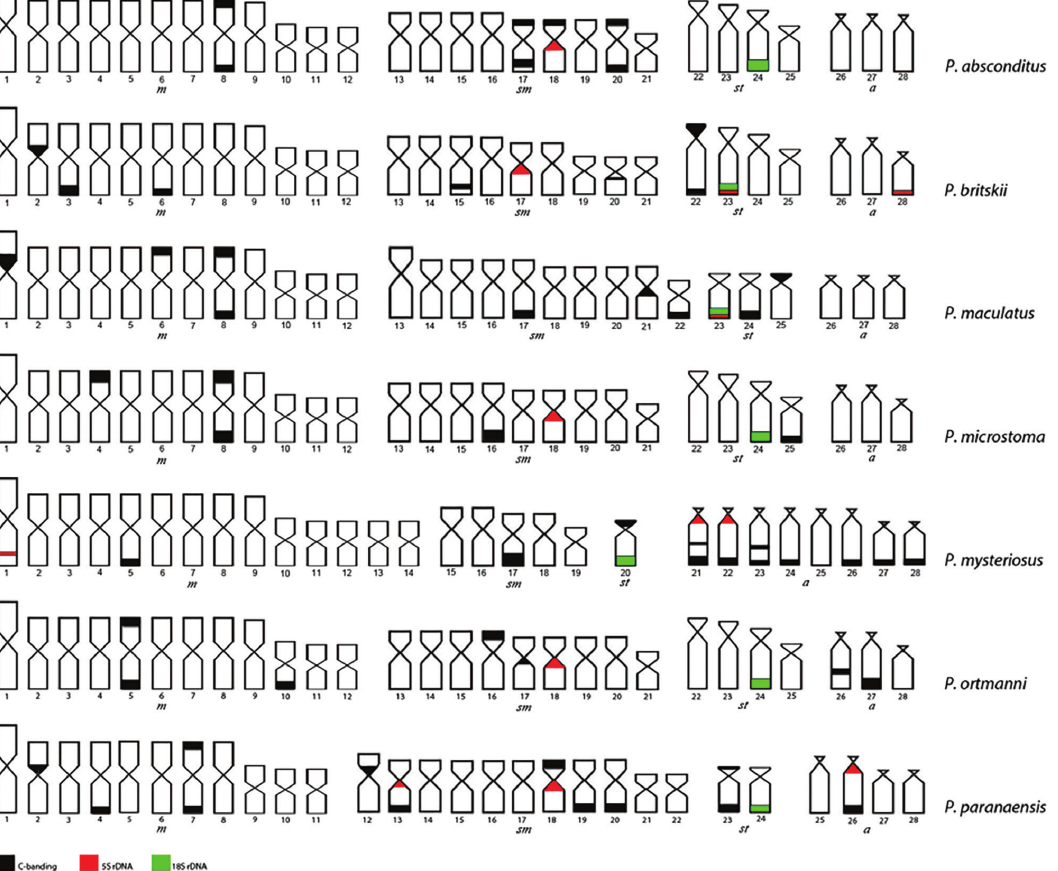
Fig. 6. Idiogram for the seven studied Pimelodus species with data obtained with different methodologies. Heterochromatin (black), 5S rDNA (red) and 18S rDNA